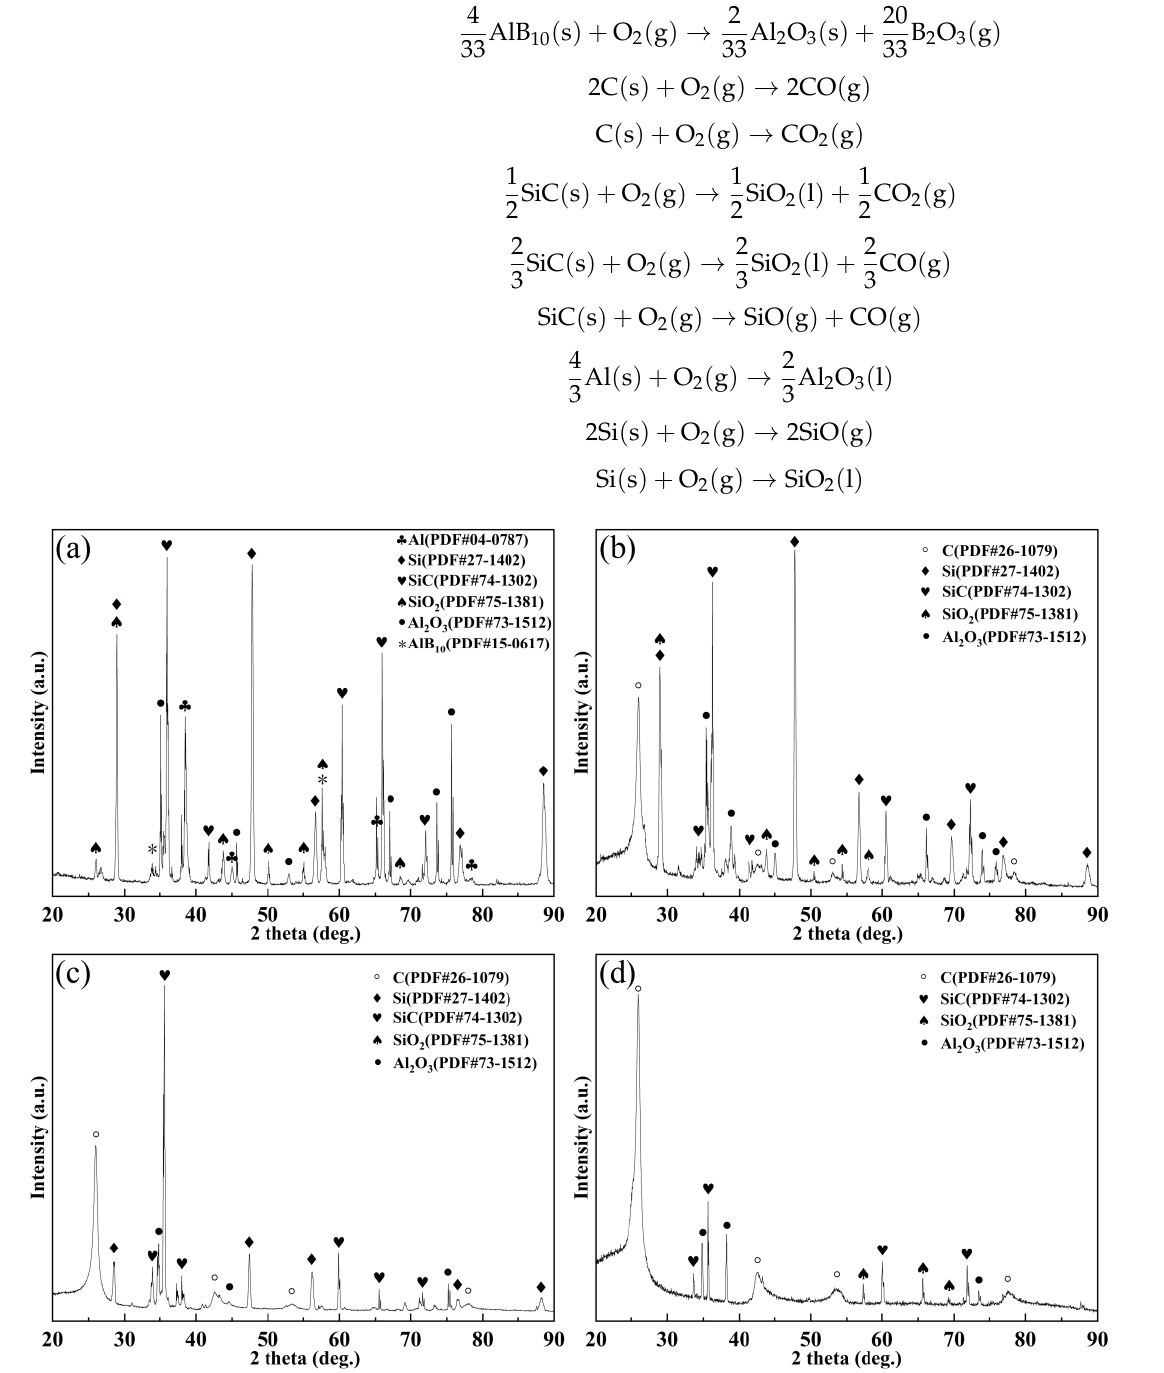
Figure 9. XRD patterns of the central region of the AlSiB-C/C composites ablated for ( a ) 25 s, ( b ) 50 s, ( c ) 100 s and ( d ) 150 s.